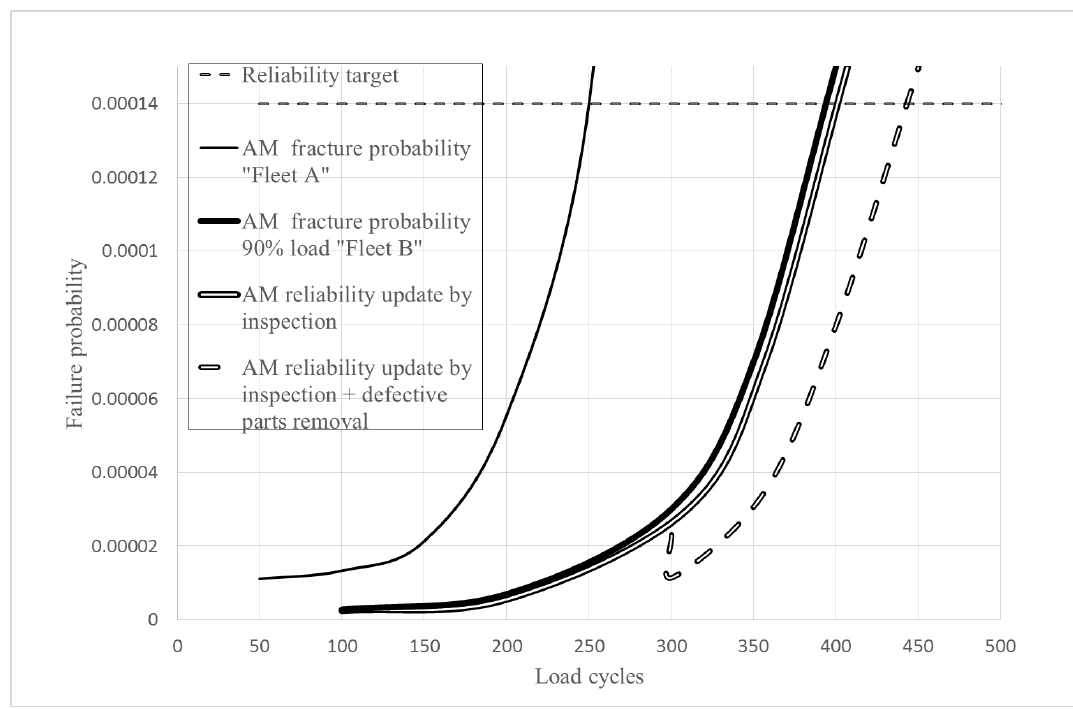
Figure 8. Failure-probability update.